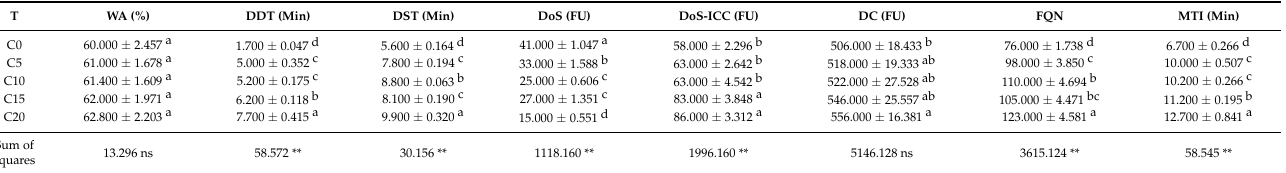
Table 4. Farinographic characteristics (mean ± SD) and their sum of squares for